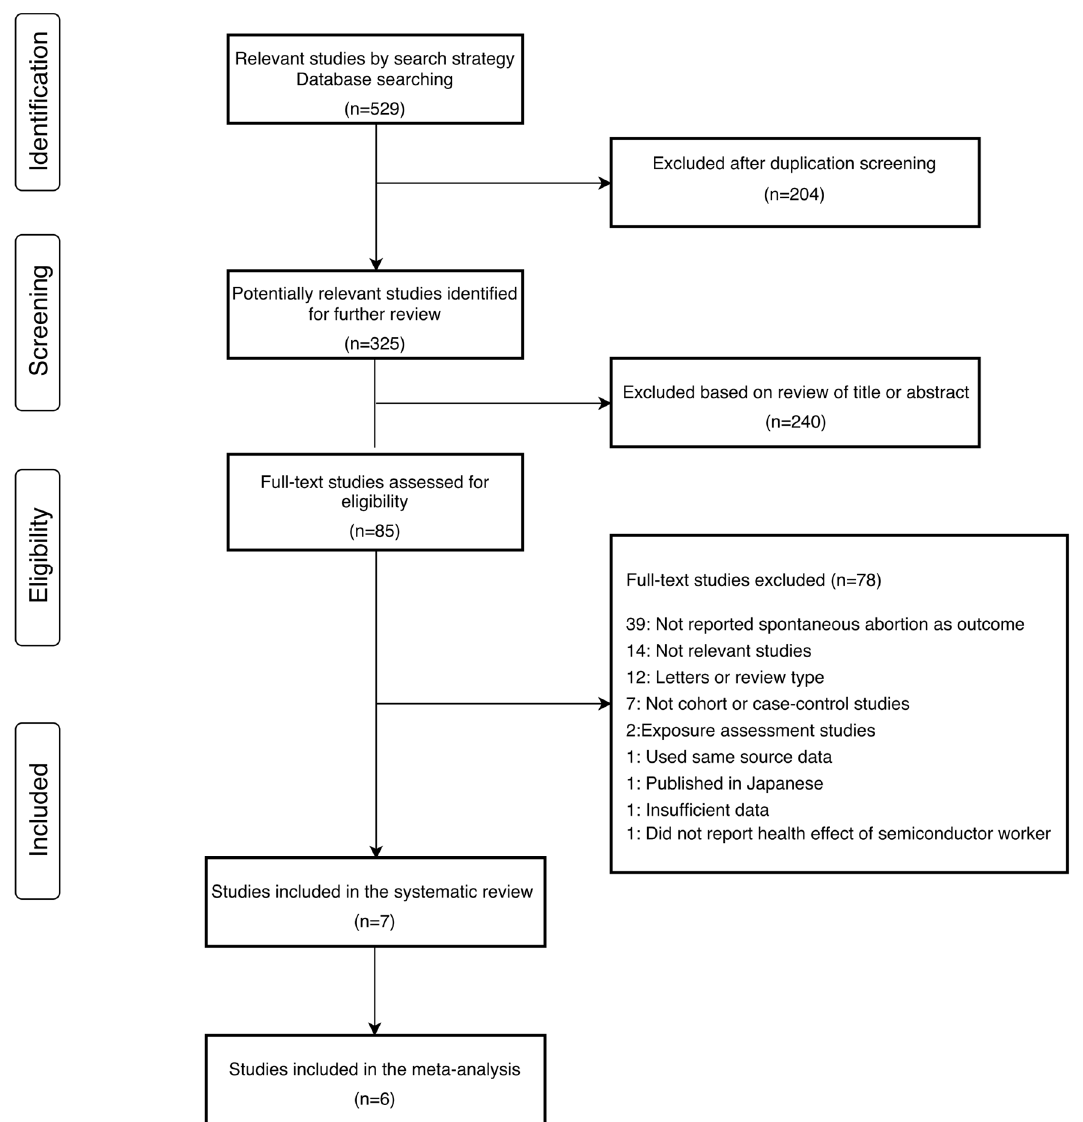
Figure 1. Progression on the selection of studies for the meta-analysis. Table 1. Meta-analysis for studies the association between the risk of spontaneous abortion and Fab